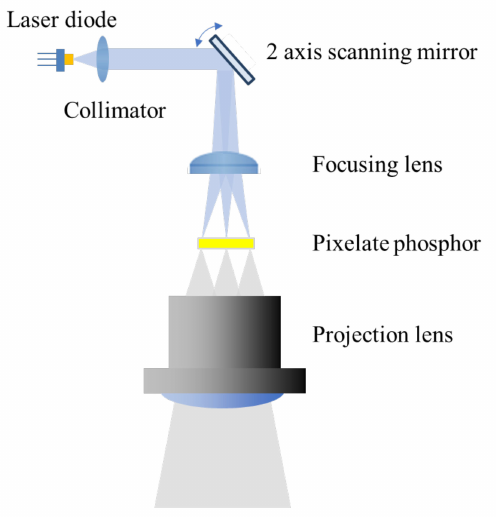
Figure 1. Schematic diagram of pixelated system using a single laser diode